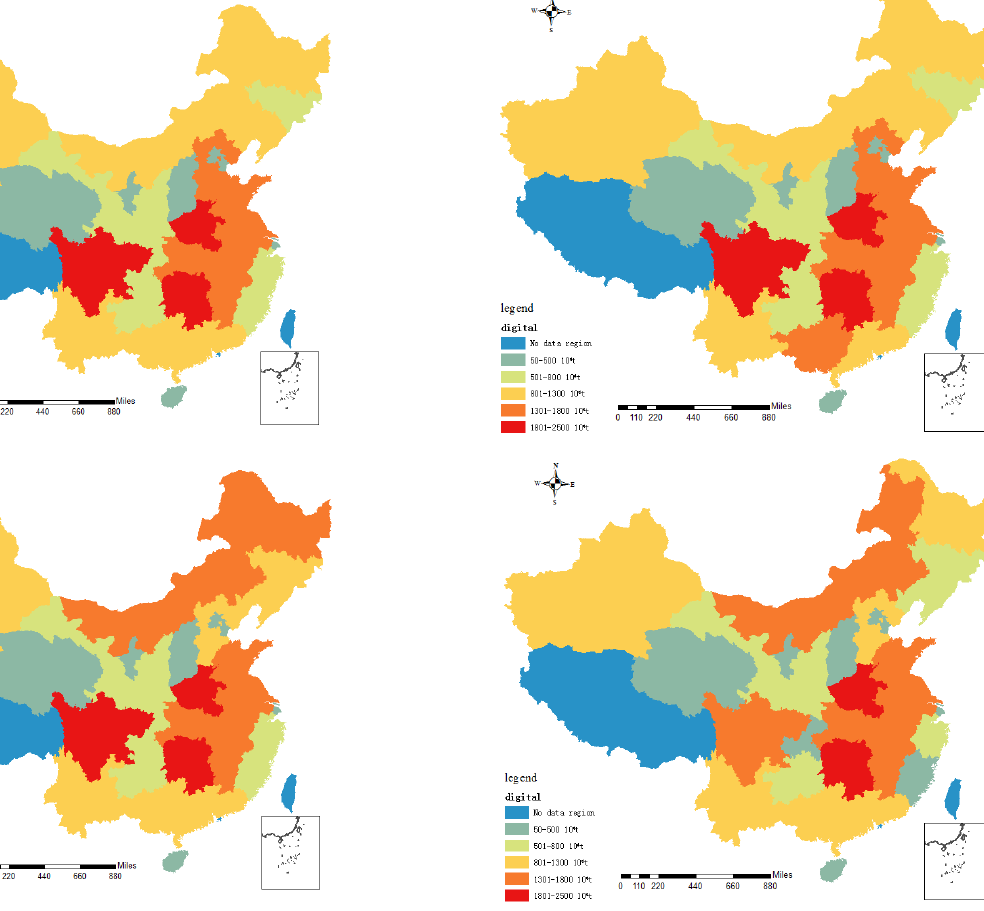
Figure 4. Agricultural carbon emissions by region in 2010, 2013, 2016, and